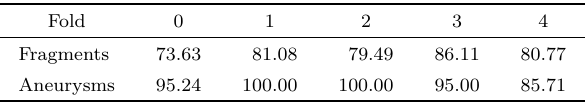
Fig. 7 Fragment examples. A has a complete aneurysm. B and C partly overlap with A, but only include a part of the aneurysm. D, E, F, and G lack aneurysms, but are misclassified. The original data for D is noisy, while E, F, and G have shapes very similar to a part of the aneurysm. Table 2 Sensitivities (%) for aneurysm fragments and whole